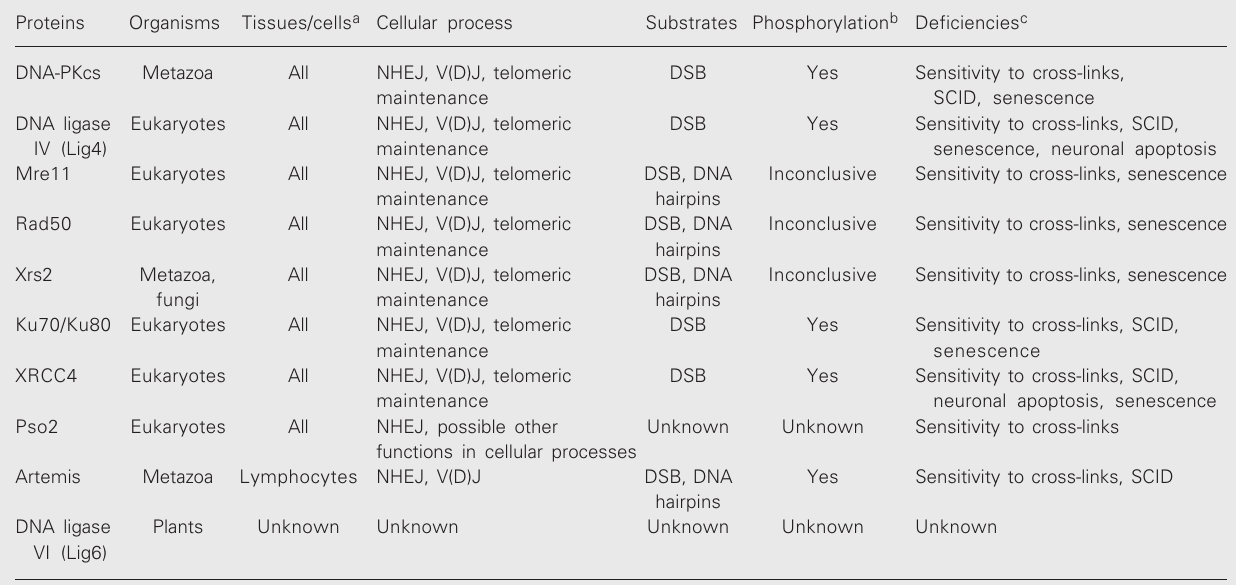
Table 1. Eukaryotic non-homologous end joining proteins. Proteins Organisms Tissues/cells a Cellular